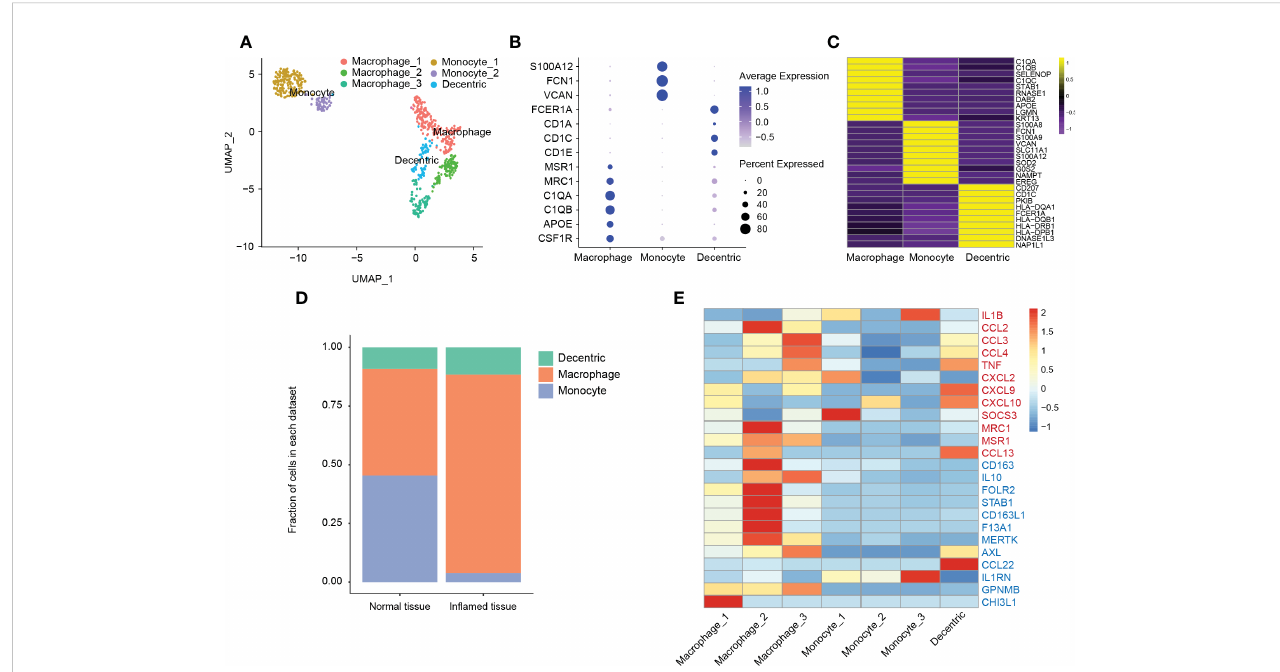
FIGURE 5 Classi fi cation and analysis of myeloid cells in cystitis glandularis. (A) U-MAP showing the dimensionality reduction distribution of different myeloid cell populations. (B) Dot plot showing the expression of classical genes of the myeloid cell subsets. (C) Heat map showing the top 10 differentially expressed genes in the myeloid cell population, ranging from yellow (high expression) to purple (low expression). (D) Cell proportion of different myeloid cell subsets in CG and normal tissues. The left panel indicates normal tissue and the right panel indicates in fl amed tissue. (E) Heat map showing the genes associated with myeloid cell function. Red genes represent the M-1 type gene set (proin fl ammatory) and blue genes express the M-2 type gene set (anti-in fl